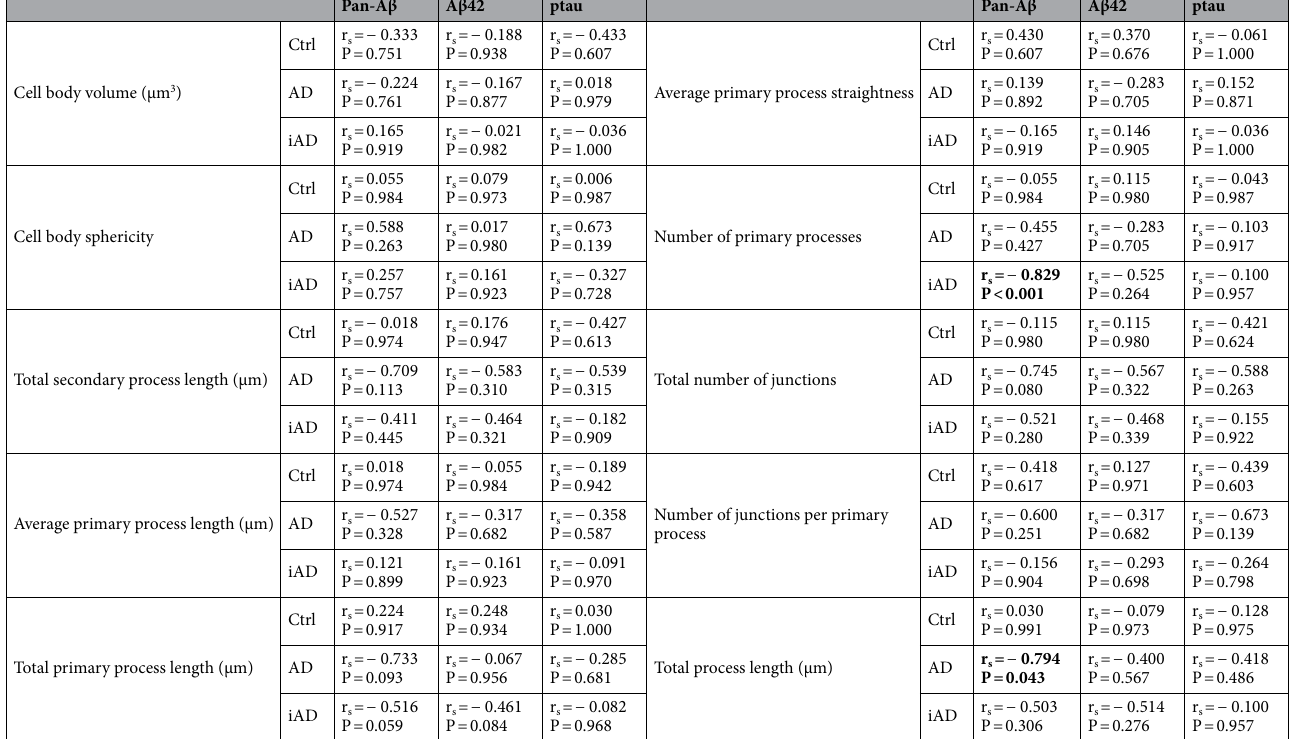
Table 3. Correlation of microglial morphological features with pan-Aβ, Aβ42 and ptau. r s : Spearman’s rank correlation coefficient. P values adjusted by Benjamini–Hochberg correction for multiple testing. Significant values in bold. Ctrl Control group.